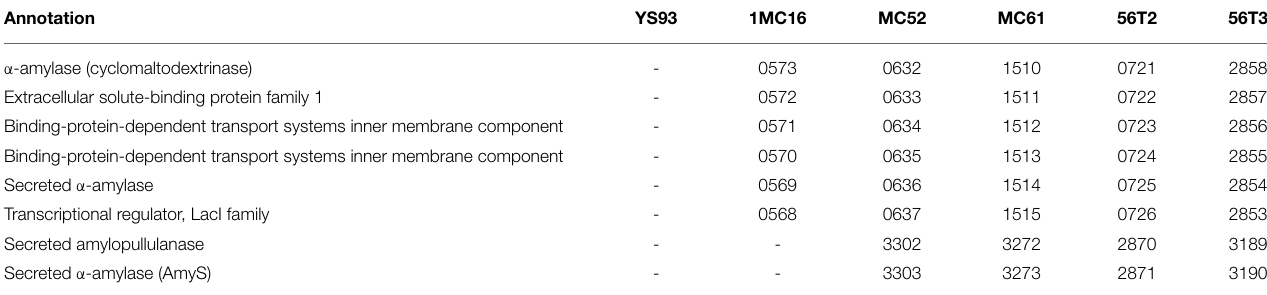
TABLE 9 | α -1,4-linked Glucooligosaccharide metabolic cluster. Annotation